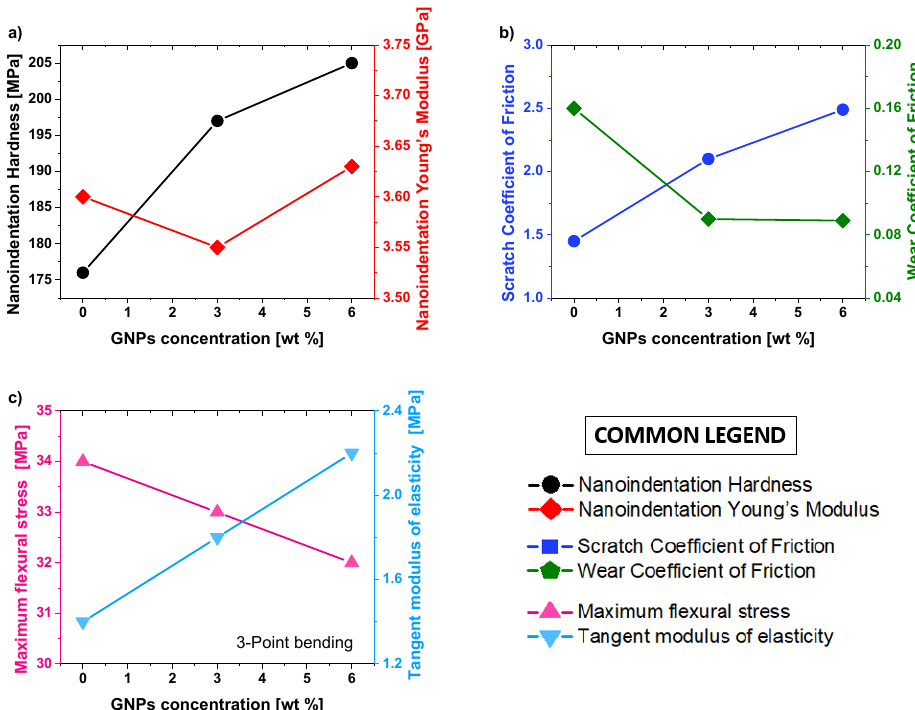
Figure 6. Comparison of mechanical properties of pure PLA, PLA filled with 3 wt% GNP and PLA reinforced with 6 wt% GNP in terms of nanoindentation hardness and Young’s modulus in ( a ), scratch and wear coefficient of friction in ( b ), maximum flexural stress and tangent modulus of elasticity in ( c ) .